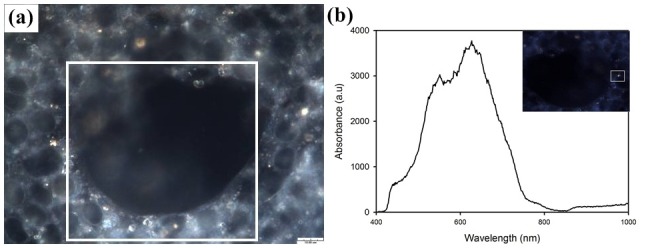
Effect of GNPs on the differentiation of MG63.(a) Dark-field hyperspectral image of MG63 treated with GNPs for 21 days; the image shows the specific nodule-like formation. (b) The corresponding scattering spectrum of the marked endosome.